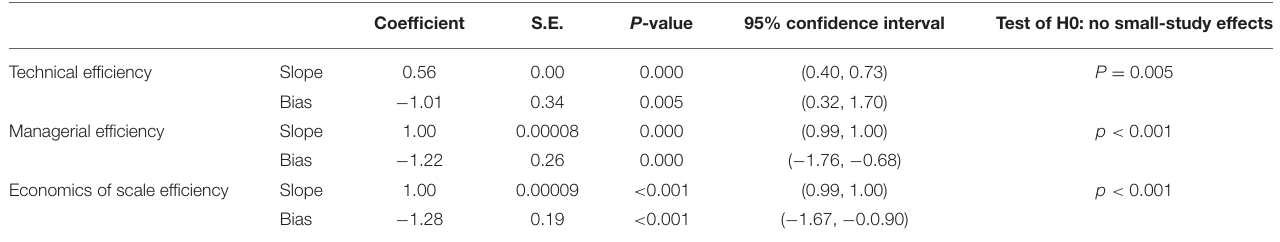
TABLE 2 | Egger’s test for small-study effects to examine the publication